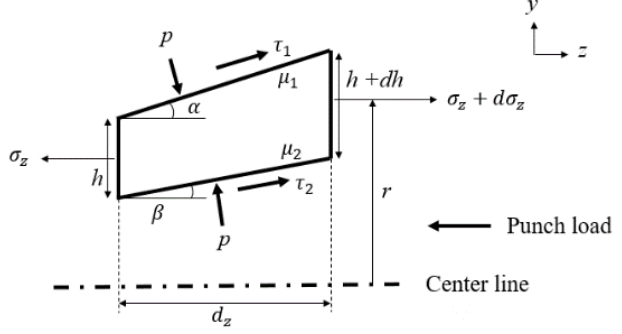
Figure 4. Stresses in a slab element during ironing process.